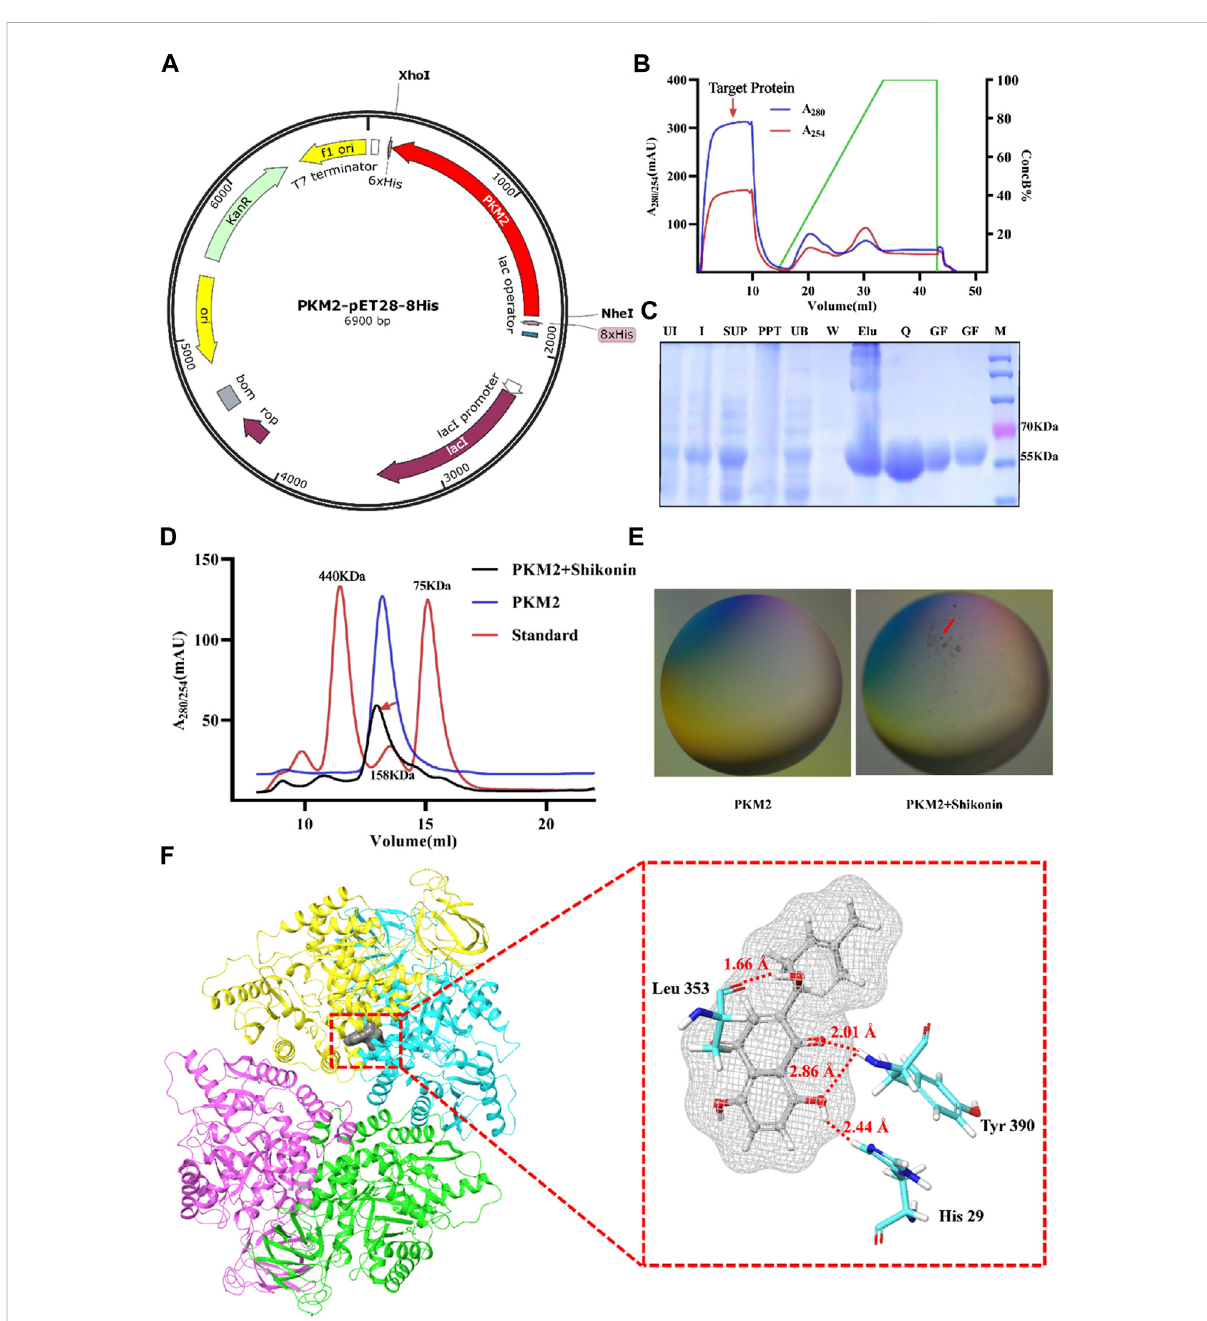
FIGURE 7 Shikonin bound to PKM2 to promote the polymerization. Map of the PKM2-pET28a (+) plasmid (A). Chromatogram of protein puri fi cation with Hi trap QHP (B) . The expression and puri fi cation of PKM2, and the purity was analyzed by 12% SDS-PAGE gels. Lane 1, uninitiated; Lane 2, initiated; Lane 3, supernatant fraction; Lane 4, precipitation fraction; Lane 5, fraction not bound to Ni-NTA; Lane 6, fraction eluted with buffer A; Lane 7, collected by buffer B; Lane 8, collected by Hi trap QHP; Lane 9-10, puri fi ed protein by Superdex 200 increase 10/300 GL without or with Shikonin (C) . Chromatogram of protein puri fi cation with Superdex 200 increase 10/300 GL without or with Shikonin (D) . Two images under a polarizing microscope (E) . Structure view of PKM2and Shikonin, and gray colorrepresents Shikonin. The pictureshows theaminoacid residueswith hydrogen bonds as red lines (F)